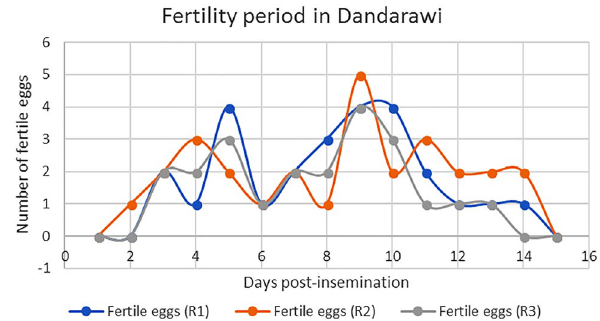
Figure 4. Diagram illustrating the fertility period in Dandarawi chickens (n = 10) after a single insemination. The experiment was repeated 3 times (R1, R2, R3). Dandarawi chickens continued laying fertile eggs for 14 days post insemination.